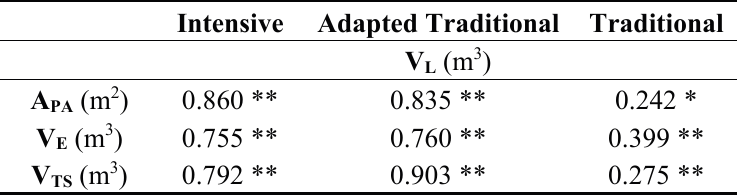
Table 3. R 2 values for correlations between LiDAR tree crown volume (V L ) and the other evaluated methods for each tree